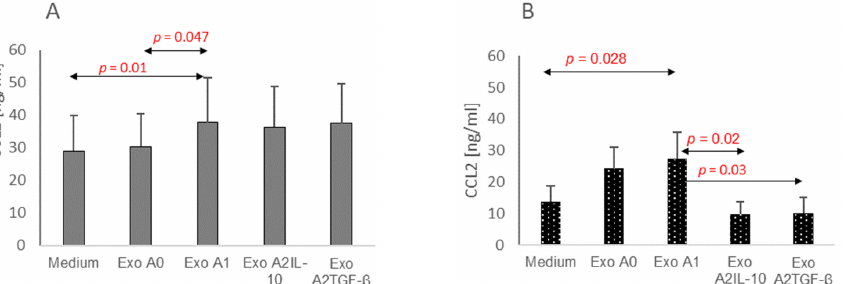
Figure 3. CCL2 chemokine production by CD4+ T-cells isolated from MS-affected patients ( A ) and healthy donors ( B ) (with excluded autoimmune disease). After separation from PBMC, every donor’s CD4+ T-cells were isolated by magnetic sorting, and cultured on 48-well culture plates (106 cells/well), with exosomes isolated from non-stimulated (Exo A0), pro-inflammatory cytokines stimulated (Exo A1) and anti-inflammatory cytokines’ (IL-10, TGF- β ) stimulated (respectively Exo A2IL-10, Exo A2TGF- β ) human astrocytes. Data shown as mean ± SEM. Comparisons between variables were made with Wilcoxon signed-rank test.